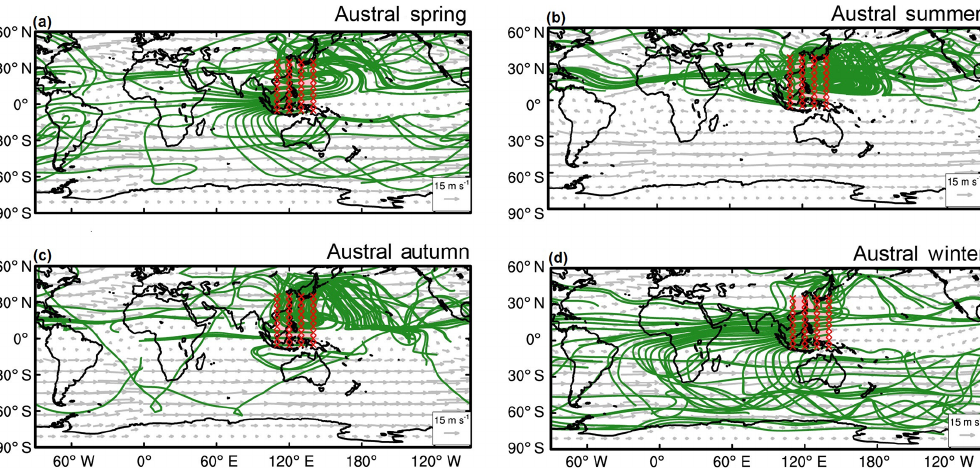
Figure 4. Ray paths (green lines) at 300hPa in (a) austral spring, (b) austral summer, (c) austral autumn, and (d) austral winter. Red points denote wave sources in the marginal seas of East Asia (5 ◦ S–35 ◦ N, 100–140 ◦ E). The wave numbers along these rays are in the range 1–5. The grey vectors indicate climatological flows.